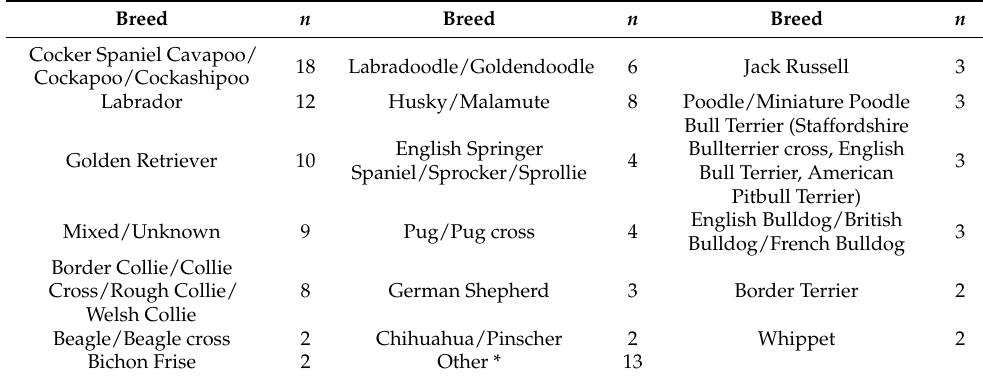
Table 3. Pet dog breeds ( n